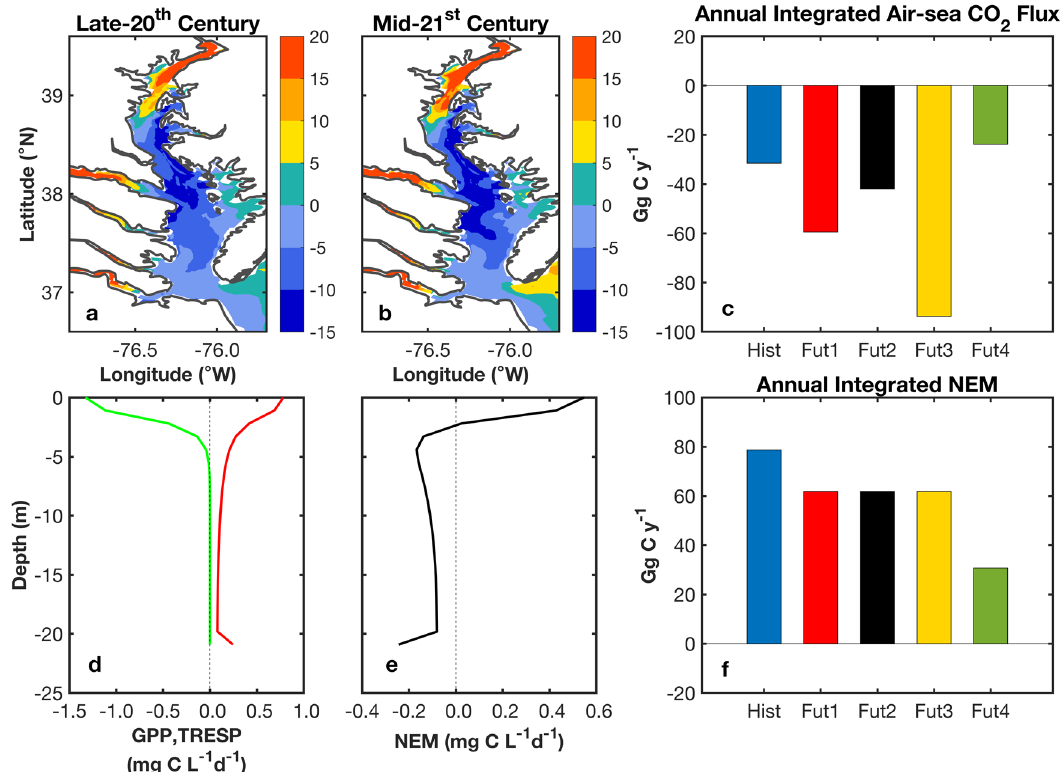
Fig. 4 Projected Changes in the air-sea CO 2 fl ux and ecosystem metabolism in Chesapeake Bay. Annual averagedair-sea fl uxesofCO 2 (mmol Cm − 2 d − 1 ) in the late-20th ( a ) and mid-21st century ( b ). Annual integrated CO 2 fl ux over the mainstem of Chesapeake Bay for the two periods ( c ). Vertical pro fi les of summer mean Total Respiration (red, positive indicating DIC generation) and Gross Primary Production (green, negative indicating DIC consumption) ( d ), and Net Ecosystem Metabolism NEM ( e ) at CB4.3 during late-20th century. ( f ) Integrated NEM. In ( c ) and ( f ) Run Hist stands for the late-20th century and Runs Fut1 — Fut4 represent four scenarios for the mid-21st century: Fut1 — shelf water p CO 2 (partial pressure of carbon dioxide) increases at 50% of atmospheric p CO 2 increase; Fut2 — increases in the atmospheric and shelf water p CO 2 are the same; Fut3 — the shelf water p CO 2 stays constant; Fut4 — riverine nutrient loading decreases by 40% and shelf water p CO 2 increases at 50% of the atmospheric p CO 2